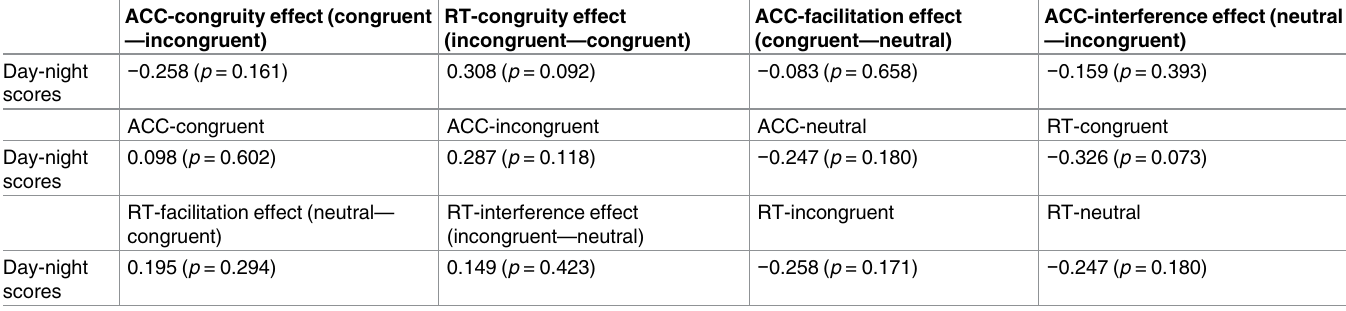
Table 3. Correlations between day-night scores and congruity, facilitation, and interferenceeffects, and accuracyand RTs in each condition.